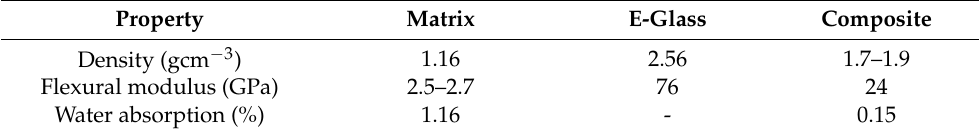
Table 1. Constituents and selected glass fiber-reinforced polymer (GFRP) properties [31].